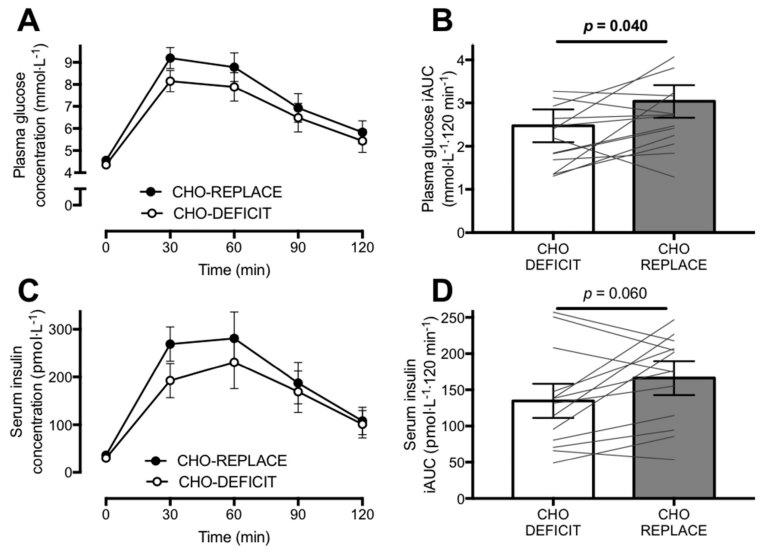
Figure 2. Postprandial glycaemia ( A , B ) and insulinemia ( C , D ) expressed as absolute concentrations ( A , C ) or as the incremental time-averaged area under the curve (iAUC; B , D ) during the oral glucose tolerance test conducted ~16 h after exercise with either carbohydrate replacement (CHO-REPLACE) or a maintenance of the exercise-induced carbohydrate deficit (CHO-DEFICIT). n = 13. Data are means ± normalized 95% CI.